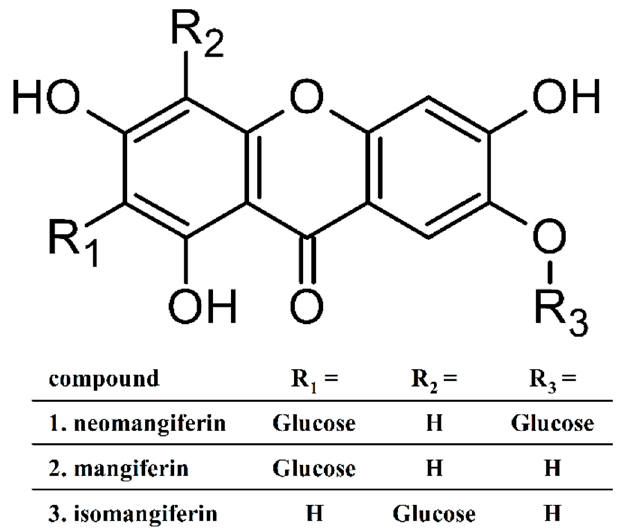
Figure 1. The structure of mangiferin (2) and the two minor xanthone C-glucosides—neomangiferin (1) and isomangiferin (3). The numbering corresponds to the peak elution sequence in the HPLC shown on Figure 7.